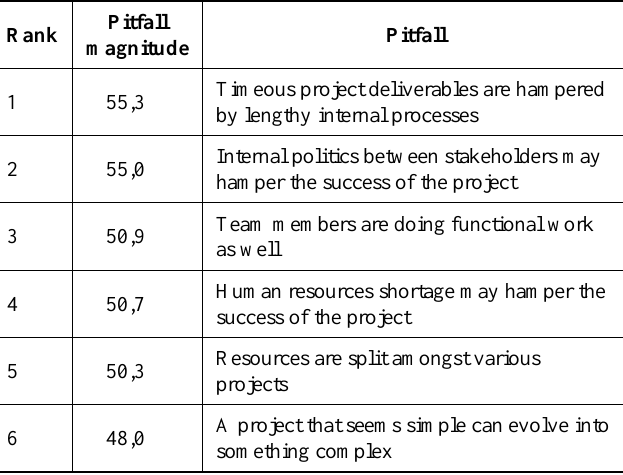
Table 4. Assessment values of the top six